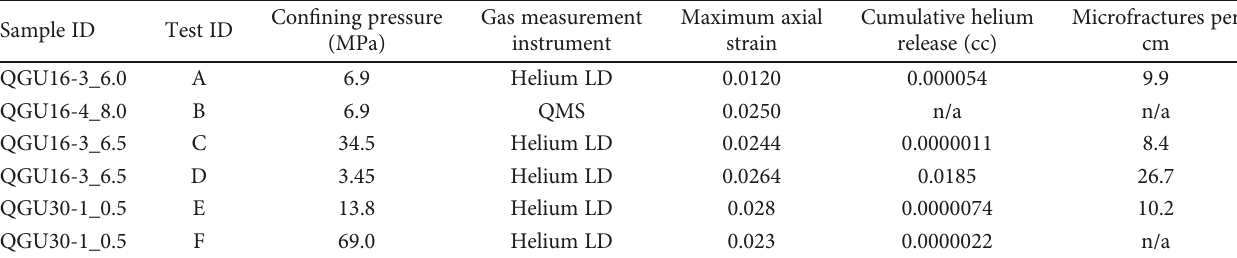
Table 1: Triaxial test matrix and gas release